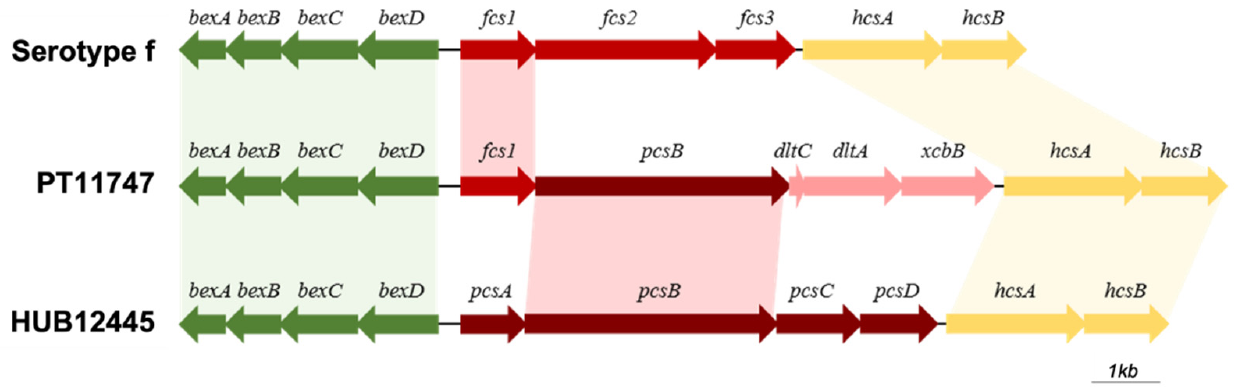
Figure 2. Schematic representation of serotype f and f-like cap loci. The first cap locus corresponds to the one that was obtained for PT11400 isolate (Hif), and it has the typical organization that is found for serotype f; the second locus represents the genetic organization of the cap locus of isolate PT11747 ( H. parainfluenzae ); the third locus shows the organization of the cap locus that was described for H. parainfluenzae HIU12445 [56]. Green arrows represent the genes from region I ( bex genes cluster); red arrows represent region II (serotype specific genes); yellow arrows represent region III ( hcs genes cluster). The orientation of the arrows indicates the direction of transcription. Shadows indicate homology between genes.